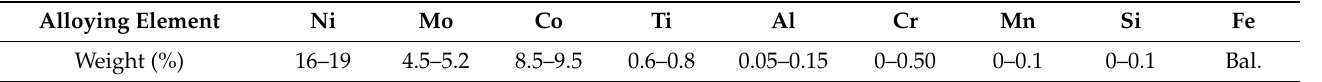
Table 1. Material composition of MS1